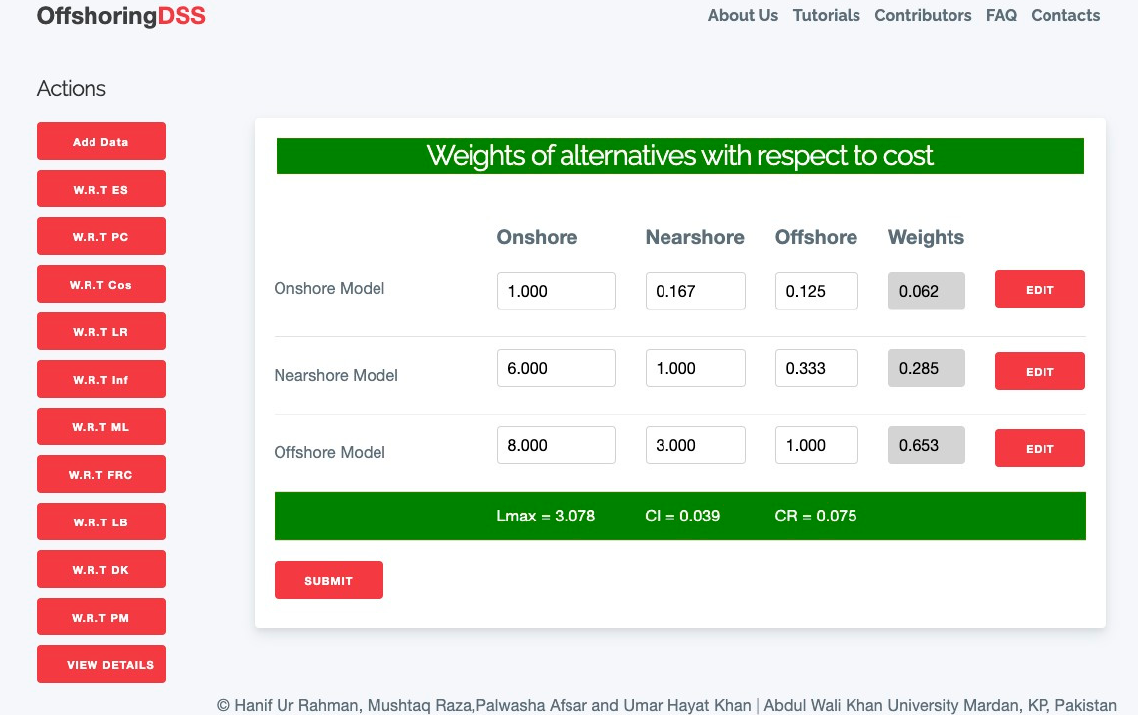
Figure A2. Alternatives weights with reference to cost and CR.